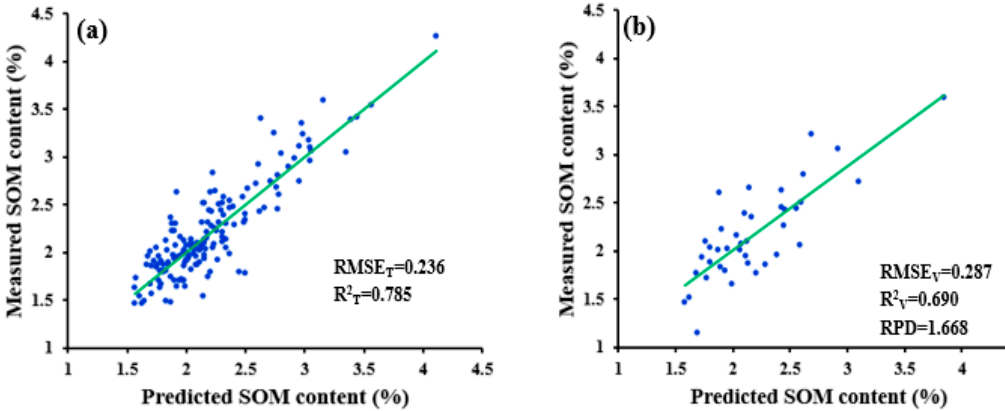
Figure 8. SOM content estimation results based on PLSR for ( a ) training and ( b ) validation set for data subjected to WPD-1/R-SWDR pretreatment.